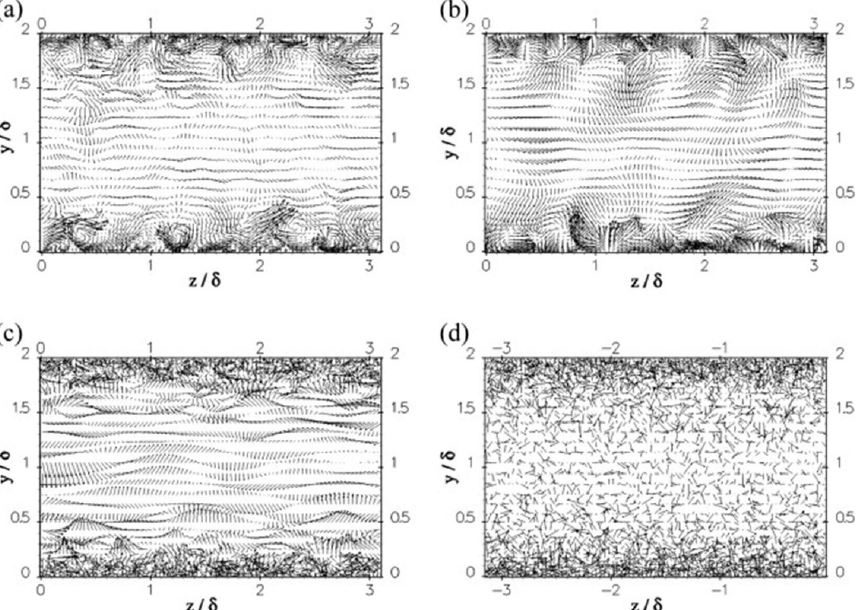
Figure 3. Velocity vectors of the LES inlet condition for hybrid simulation of channel flow: ( a ) precursor LES, ( b ) SEM, ( c ) Batten’s method, ( d ) random method (y/ δ : normalized y distance, z/ δ : normalized z distance, δ : initial boundary layer thickness) [143].